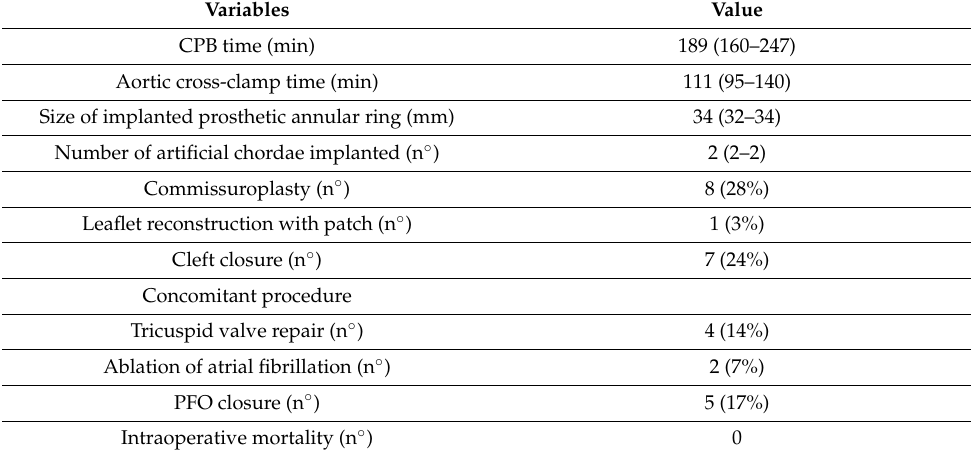
Table 3. Intraoperative details.